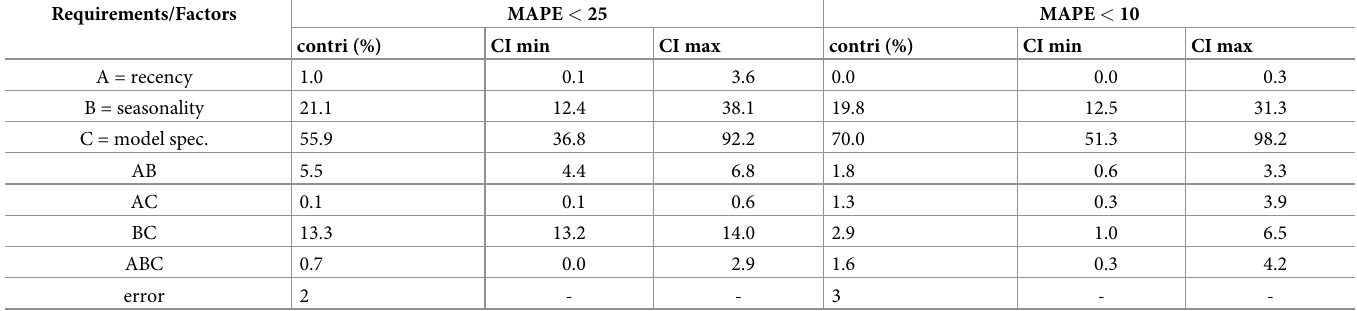
cases in which there is a lack of enough training data for specific attractions. B. Statistical analyses. The statistical significance of our results is presented (according to a t-test with significance level of α = 0.05). Specifically, we report 95% confidence intervals for the effect of each tourism requirement factor on the prediction task (according to our factorial anal- ysis presented in Section 3.3) for both considered scenarios of indoor and outdoor attractions. These are shown in Tables 16 and 17, respectively. In general terms, we find that, with the speci- fied statistical significance, model specialization and seasonality have the largest contributions. Table 16. Contribution of each of tourism prediction requirements: Recency, seasonality, model specialization and their interactions into the response variable in indoor attractions (U.K. Museums and Galleries); results for MAPE < 10 and MAPE < 25 in 5 runs. Minimum and maximum confidence interval for 95% confidence are reported.